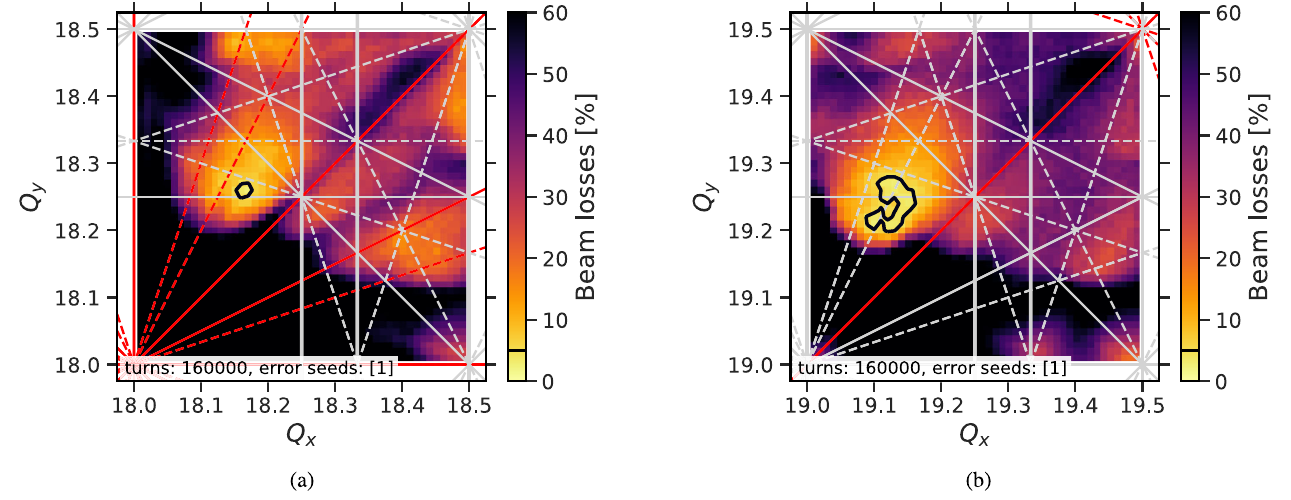
FIG. 22. FFSC results for beam loss using the full field error model as a function of the transverse tunes above the integer resonances.